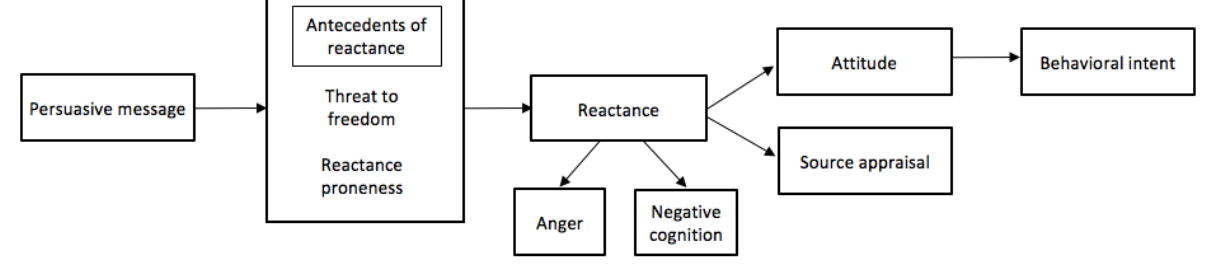
Figure 2. An intertwined process cognitive-affective model as described in Dillard and Shen with the addition of source appraisal from